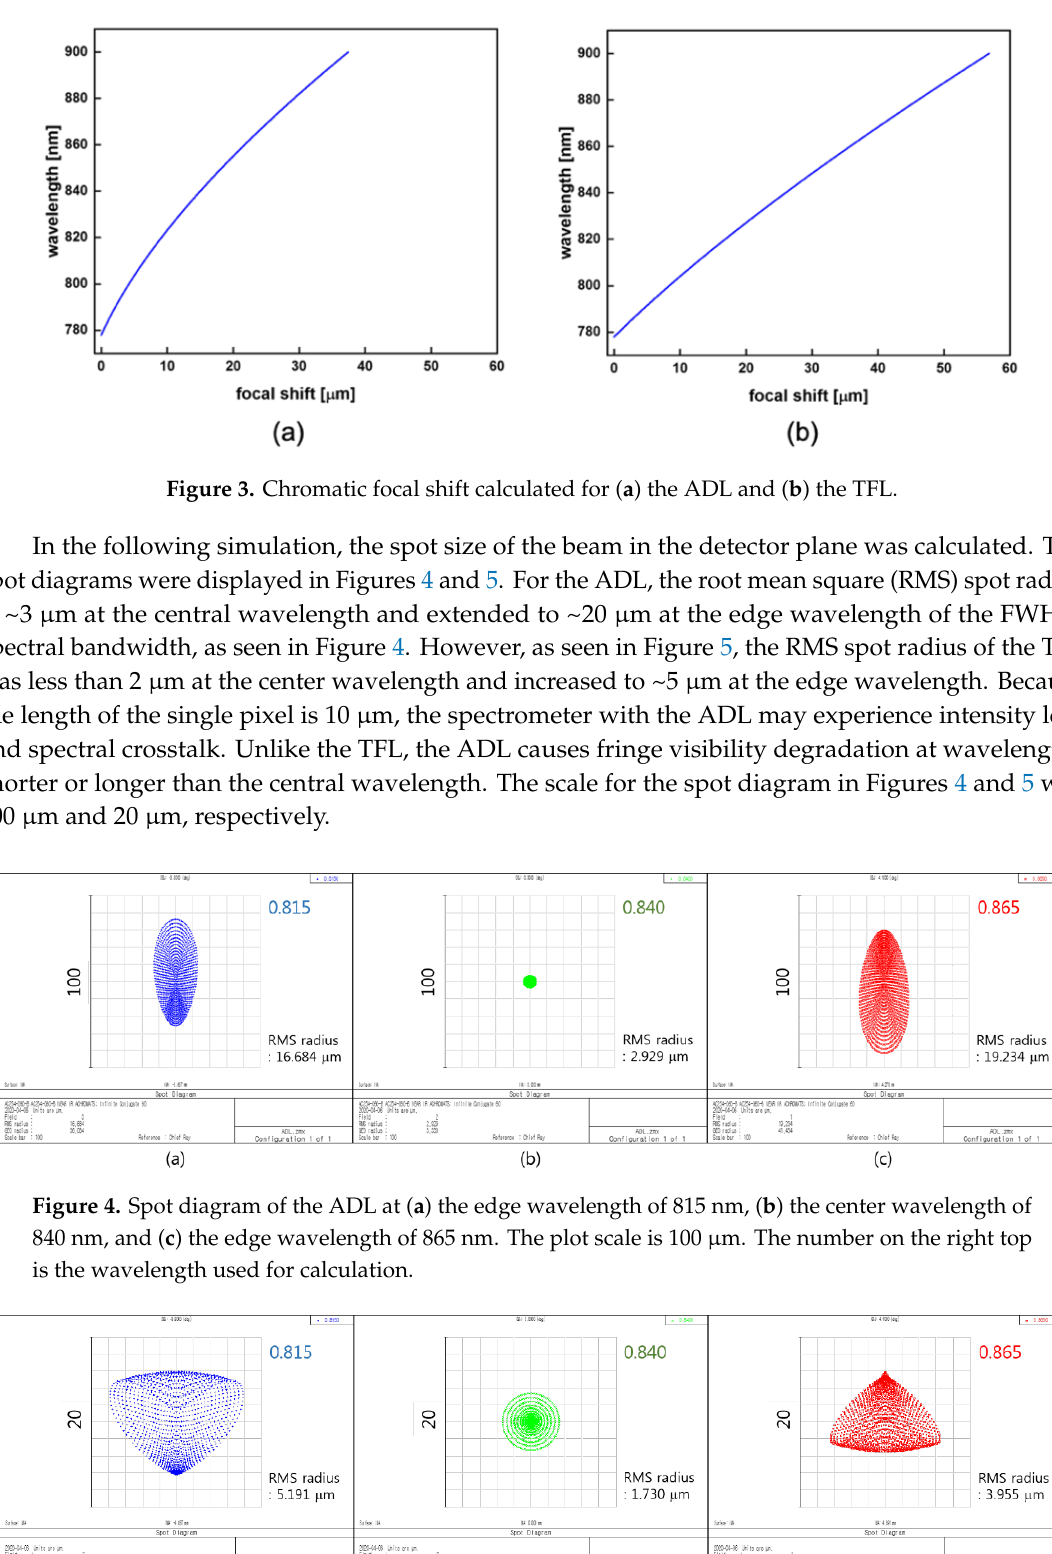
Figure 3. Chromatic focal shift calculated for ( a ) the ADL and ( b ) the TFL.